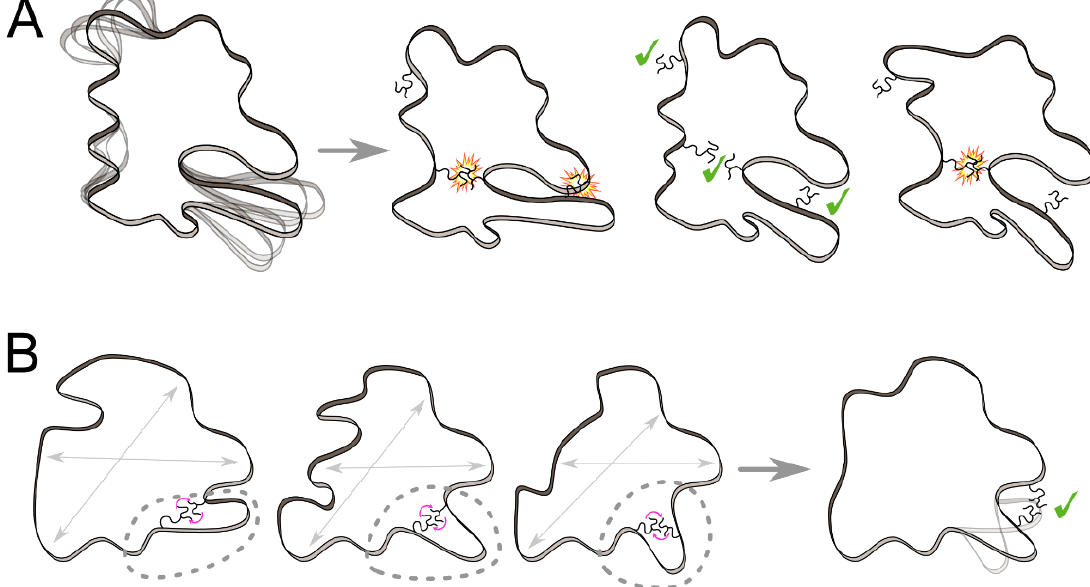
Figure 4. Flexible-backbone approaches facilitating the successful design of more diverse protein variants. ( A ) By employing a structural ensemble of a given protein, a larger variety of residues can be introduced to additional positions (green ticks), including those buried in the protein core, which would otherwise cause steric clashes (orange explosion-like shapes). ( B ) Data on protein dynamics encoded in different experimental structures or predicted ensembles can be extracted in the form of tertiary motifs (grey dotted circle) of interacting residues (pink arrows). Analogously, machine learning methods can learn and generalize the data to inspire novel backbone movements (grey arrows). The derived knowledge then enables the efficient application of more pronounced, yet physically correct, backbone perturbations during the design procedure.